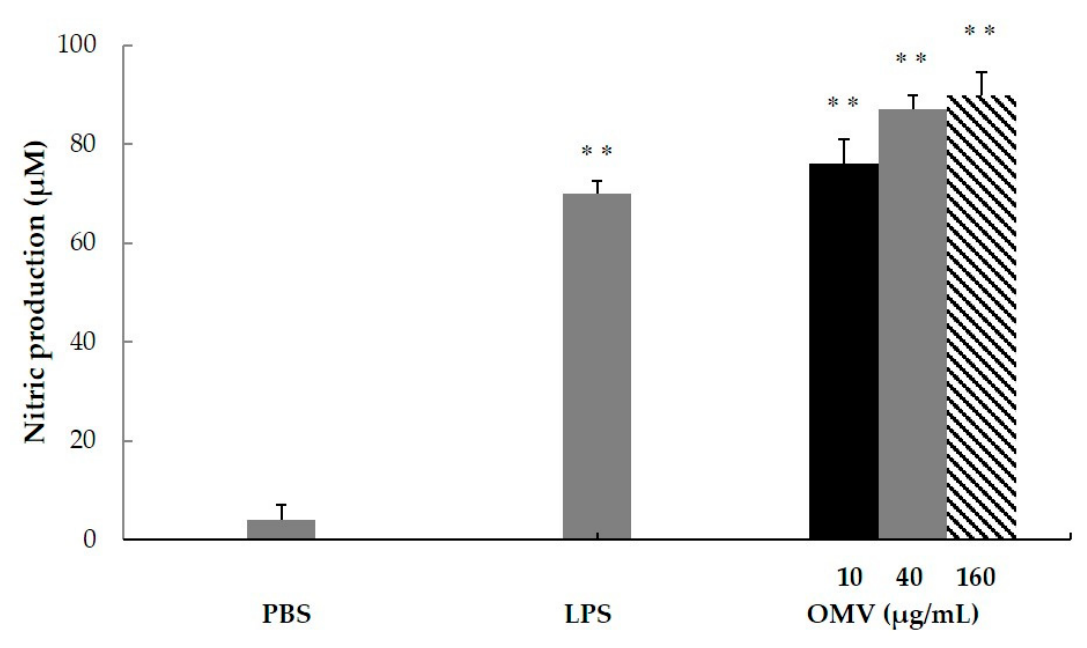
Figure 3. Macrophages generate nitric oxide in response to OMV-F4 Escherichia coli enterotoxigenic Escherichia coli (ETEC). The capacity of the OMV antigenic complexes to induce production of nitric oxide in the murine macrophage cell line RAW 264.7 was studied at three different concentrations (10, 40 and 160 µg/mL). The results are shown as the mean NO 2 − levels for triplicate cultures ± SD. NO 2 − levels were significantly greater (** p < 0.01) than those in supernatants from splenic cells incubated with culture medium alone.